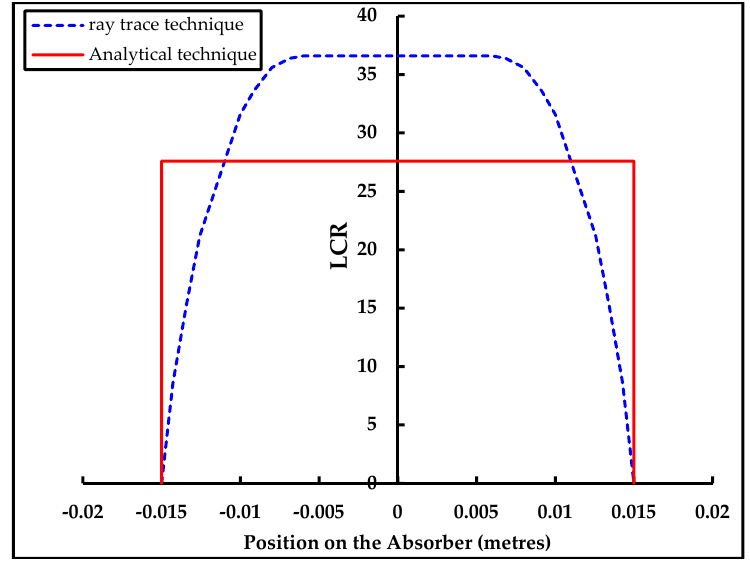
Figure 9. Distribution of LCR on the horizontal receiver surface for the aperture (LFRSC) design, absorber width a = 3 cm.